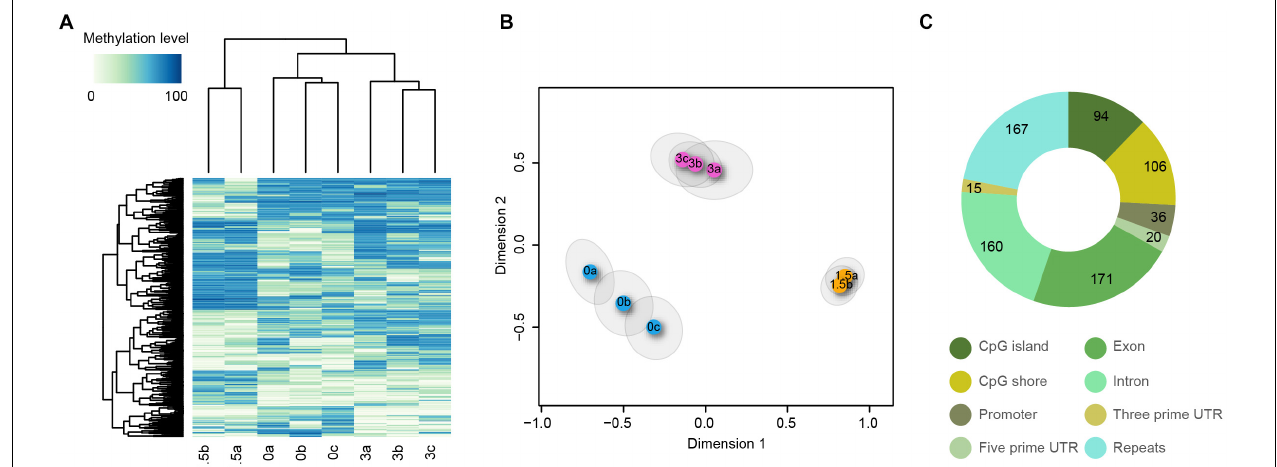
FIGURE 2 | Differential methylation in the CpG context for within-generational plasticity. (A) Heatmap of methylation levels for DMRs is shown with the color key in the upper left corner. Column labels indicate the sample code represented by the combination of the increased temperature (0, 1.5, 3) and individual fish number (a, b, and c). (B) Multidimensional scaling analysis of DMRs. Each circle corresponds to one fish sample and experimental groups are marked by different colors. 95% confidence ellipses from 1,000 bootstrapping are shown for each sample. No overlap of ellipses for CpG DMRs indicates that CpG methylation patterns are significantly different among experimental groups. (C) Distribution of DMRs for CpG contexts across categorized genomic